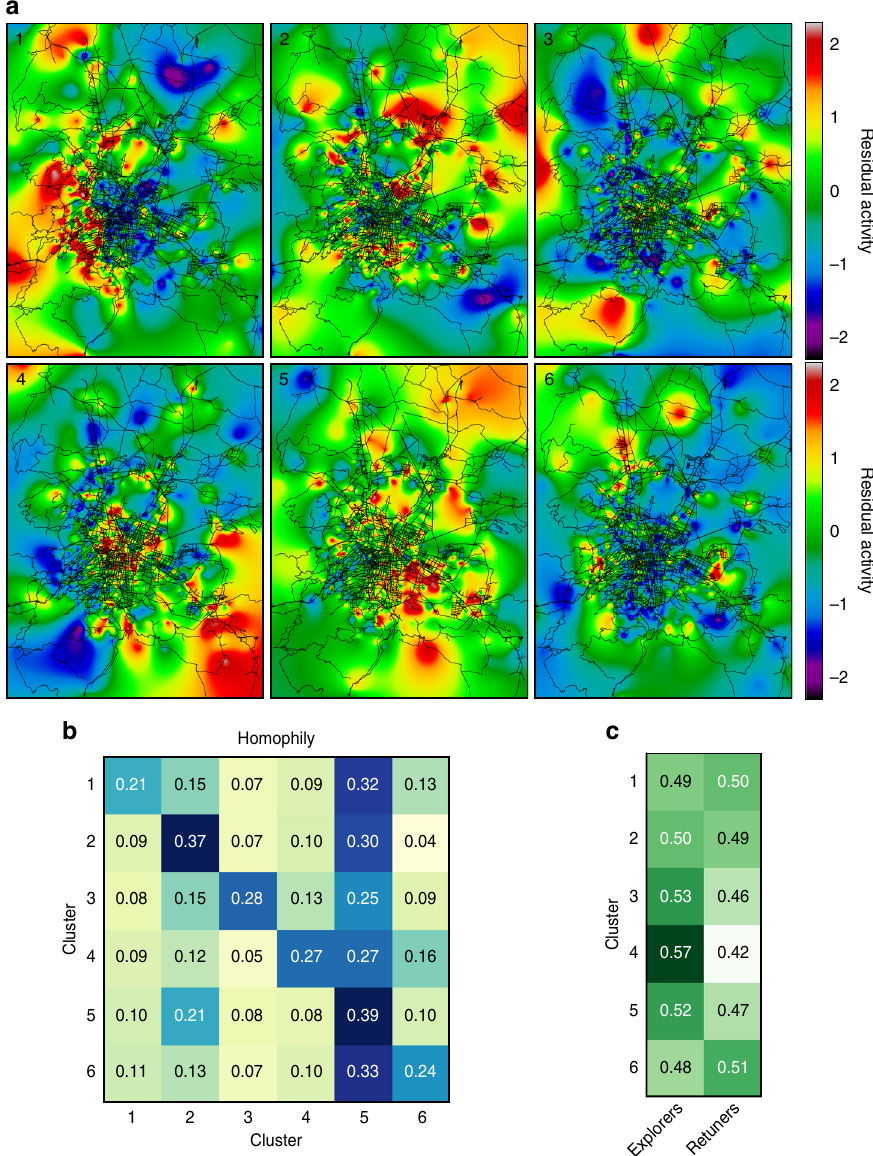
Fig. 5 Identi fi ed lifestyles II. a Cell towers residual activity by clusters. b Clusters ’ homophily. As expected, each user tends to contact the users that belong to the same clusters or cluster 5 “ uncategorized, ” which is the cluster with the highest number of users. Remarkably, there is a slight preference to contact cluster 2, the homemakers, which represent the oldest group. c Distribution of returners and explorers across the clusters (see Supplementary Figure 11 – 16, 21 for further information). Maps in this fi gure were created using the software QGIS using OpenStreetMap